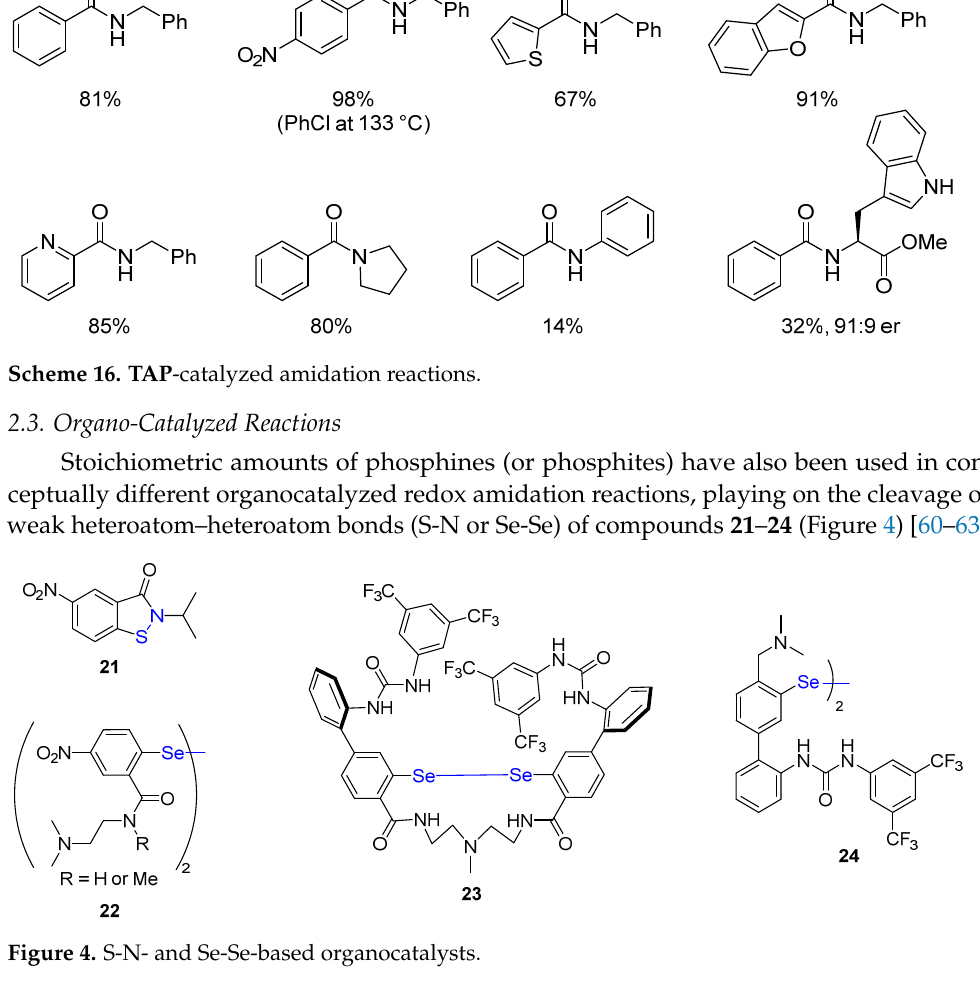
Figure 4. S ‐ N ‐ and Se ‐ Se ‐ based organocatalysts.